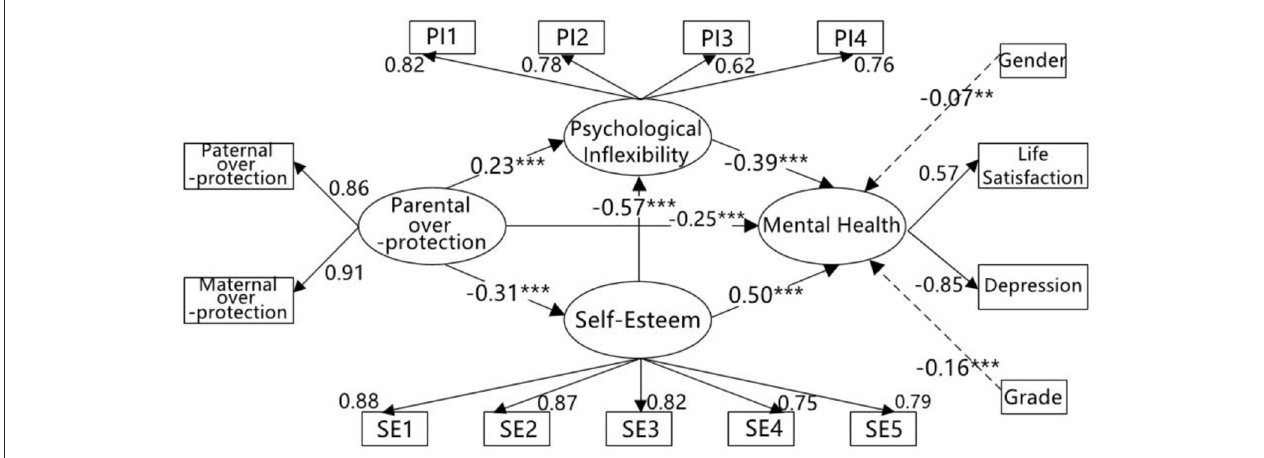
FIGURE 3 | The mediating role of self-esteem and psychological inflexibility between parental over-protection and mental health. PI1–PI4, four parcels of psychological inflexibility; SE1–SE5, five parcels of self-esteem; ** p < 0.01; *** p < 0.001.